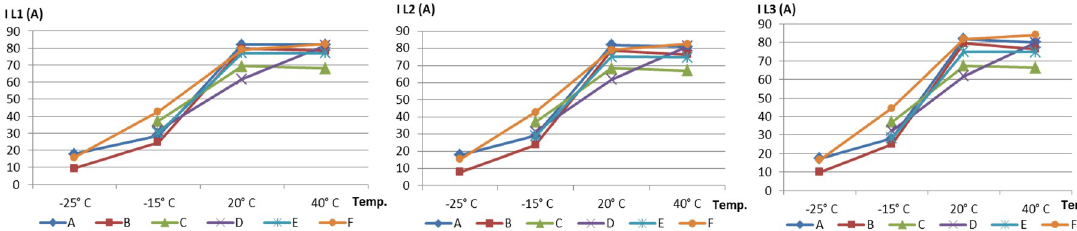
Figure 2. Current total harmonic distortion variation, with temperature per phase.